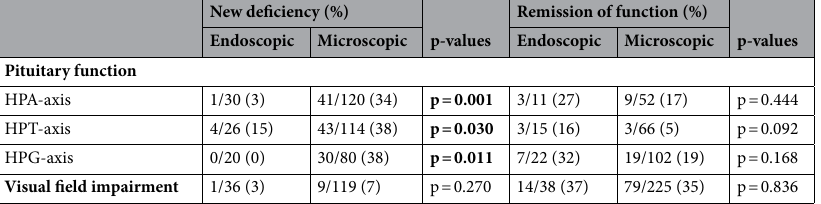
Table 3. Postoperative pituitary function and visual field impairment in patients with pituitary adenomas undergoing endoscopic or microscopic surgery, showing proportion of patient developing new pituitary deficiencies or experiencing normalization of pituitary function (remission). p -values < 0.05 was regarded as stastically significant and highlighted in